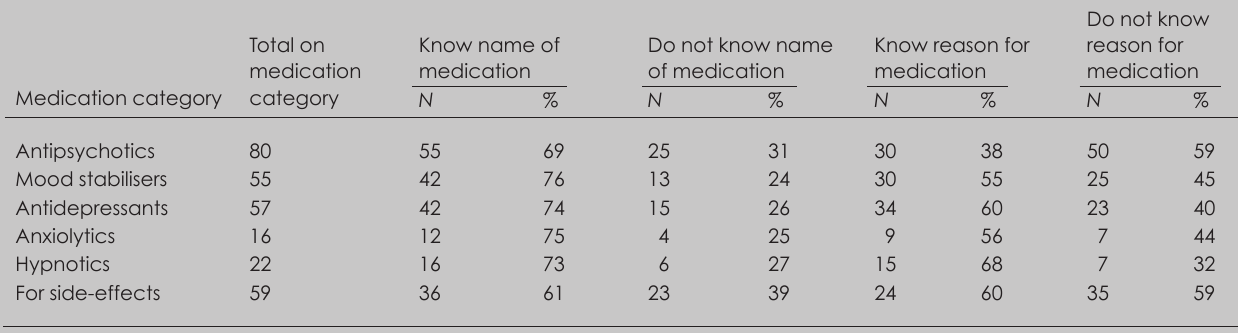
Table III. Medication category and knowledge related to it